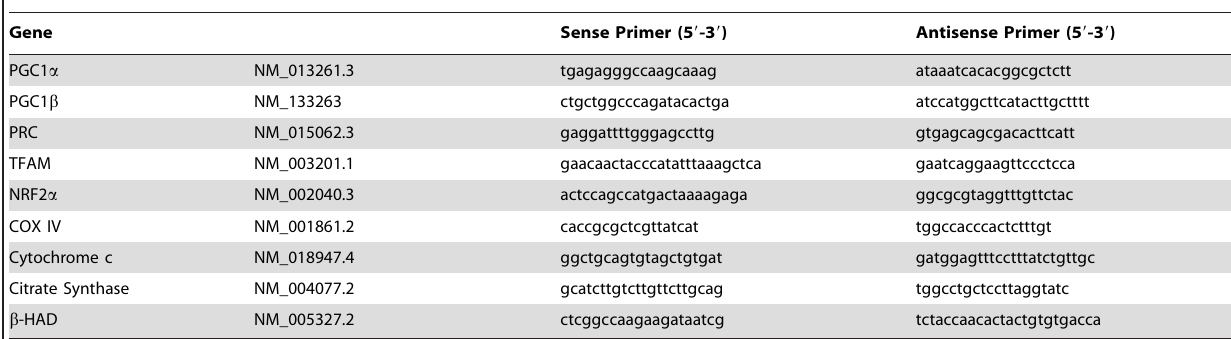
Table 1. Primer sequences used for